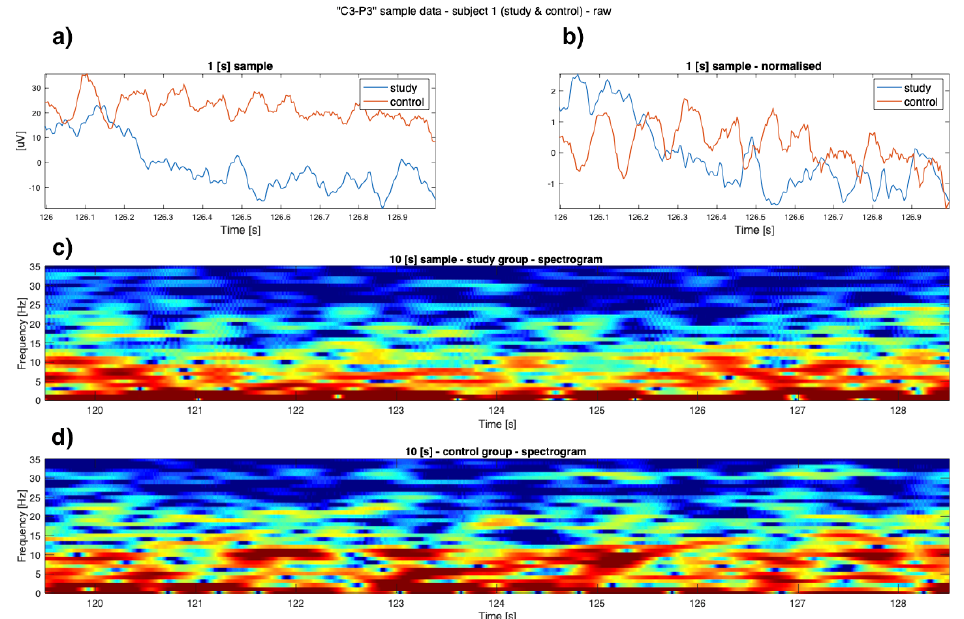
Figure 2. Example raw data from channel ’C3-P3’ : ( a ) time-series of both study group and control group (1 [s]); ( b ) normalised time series of study group and control group (1 [s]); ( c ) 10 [s] sample of FASD (top spectrogram); ( d ) 10 [s] of healthy control (bottom spectrogram)—sample